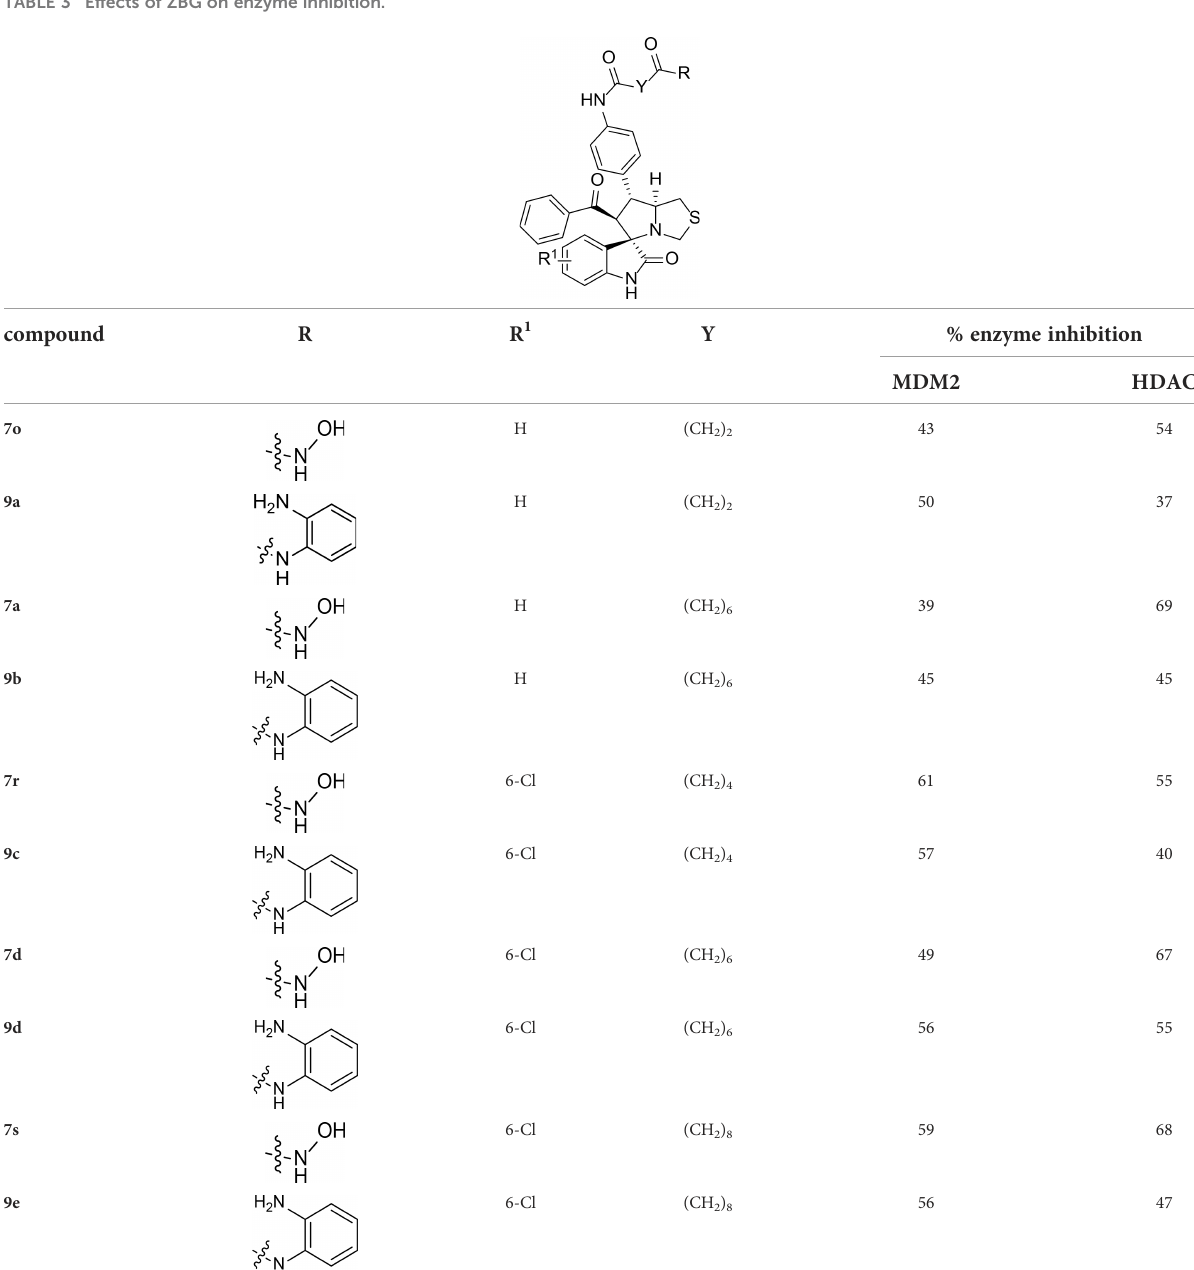
TABLE 3 Effects of ZBG on enzyme